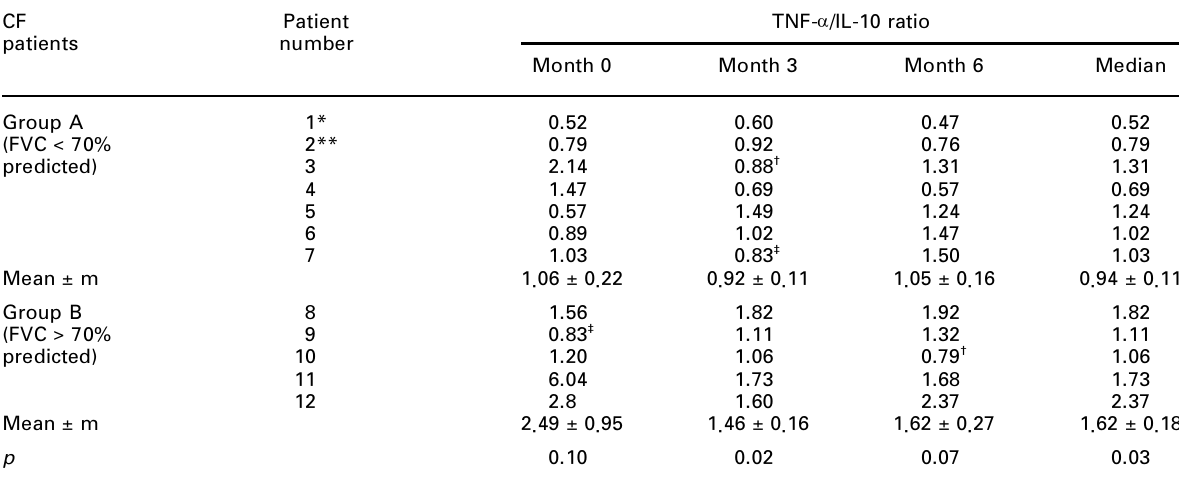
Table 2. Semi-annual changes of TNF- a /IL-10 ratios in CF patients CF